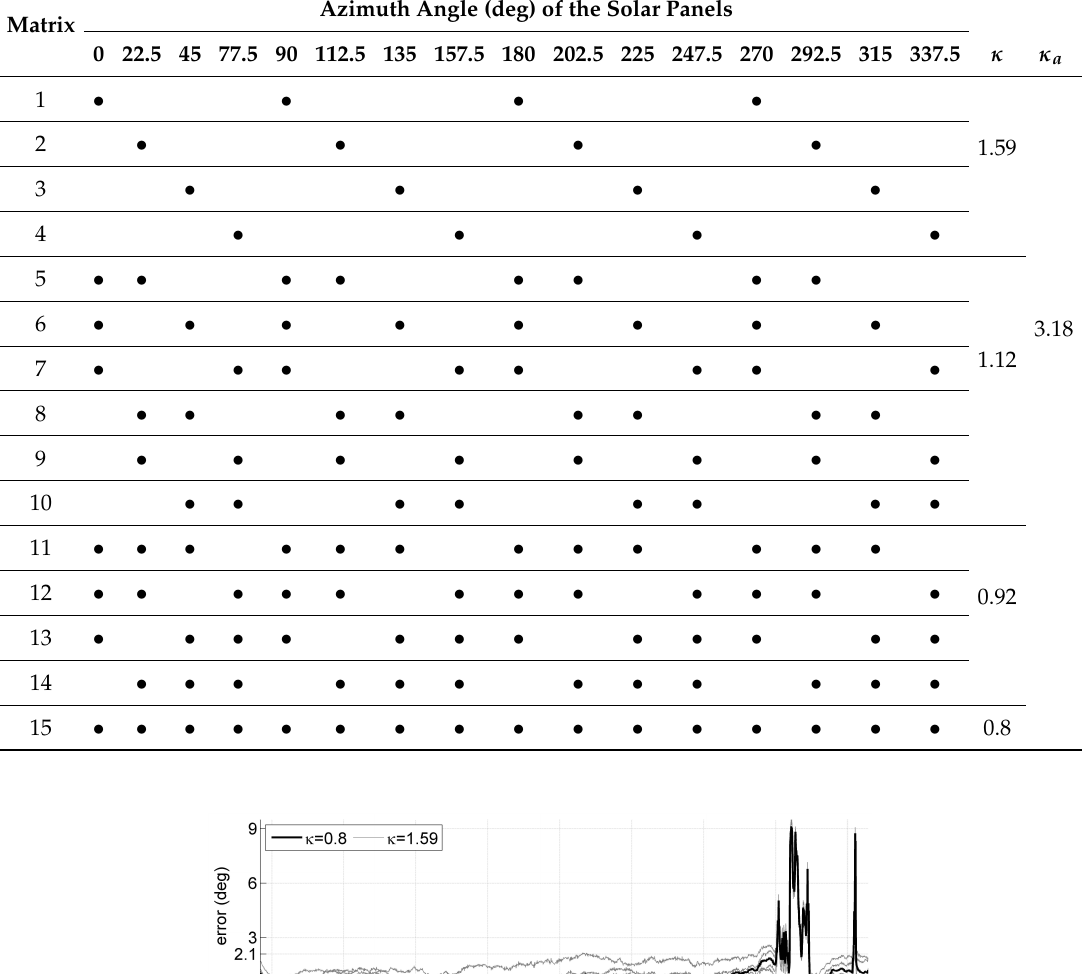
Table 4. The configuration of 15 orientation matrices and their κ and κ a , with lit solar panels marked by black dot.